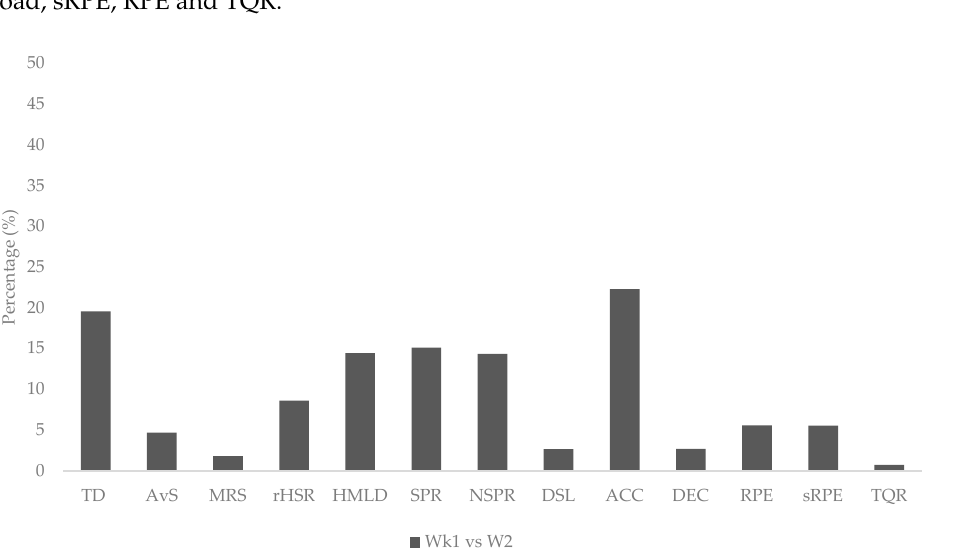
Figure 3. Mean training load and recovery status per session according to comparison between weekly microcycles.